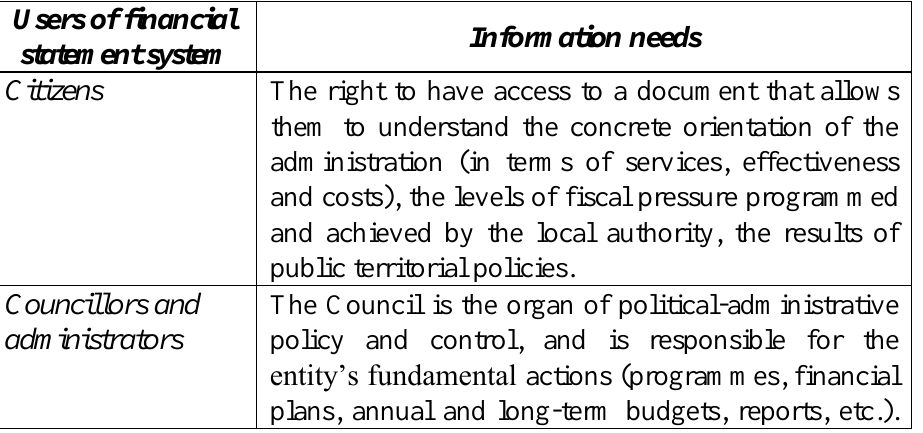
Table 1: Information Needs of Users of the Financial Statement System Users of